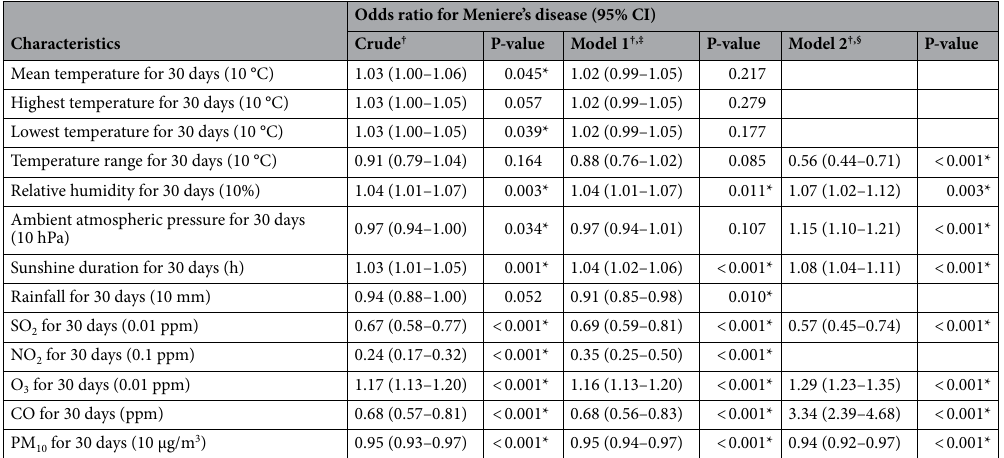
Table 2. Crude and adjusted odd ratios (95% confidence interval, CI) of the meteorological and pollution matter (mean of 30 days before index date) for Meniere’s disease. CCI Charlson comorbidity index, DBP diastolic blood pressure, SBP systolic blood pressure. *Conditional logistic regression model, Significance at P < 0.05. † Stratified model for age, sex, income, and region of residence. ‡ A model 1 was adjusted for total cholesterol, SBP, DBP, fasting blood glucose, obesity, smoking status, alcohol consumption, and CCI score. § A model 2 was adjusted for full insertion using forward selection method. The model was finally adjusted for temperature range, relative humidity, ambient atmospheric pressure, sunshine duration, SO 2 , O 3 , CO, PM 10 , obesity, smoking status, CCI score, fasting blood glucose, SBP, benign paroxysmal vertigo, vestibular neuronitis, and other peripheral